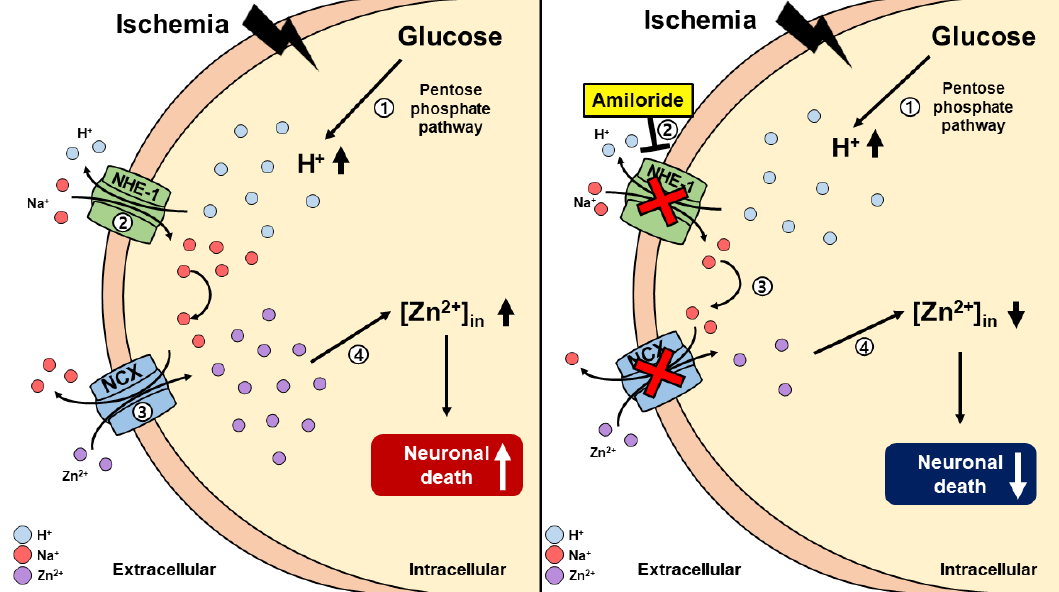
sodium–hydrogen exchanger-1 (NHE-1) channel. ( A ) [1] Global cerebral ischemia insult results